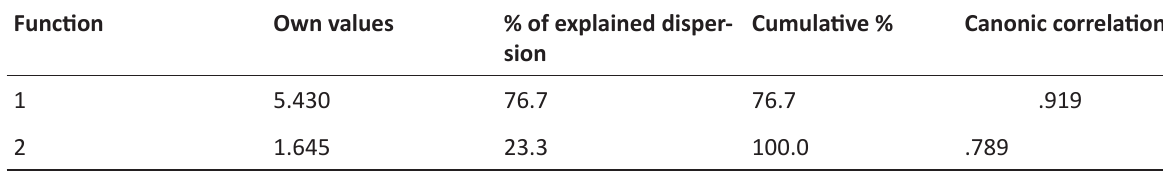
Table 2. Canonic discriminant function. Wilks’ Lambda, Functions’ check